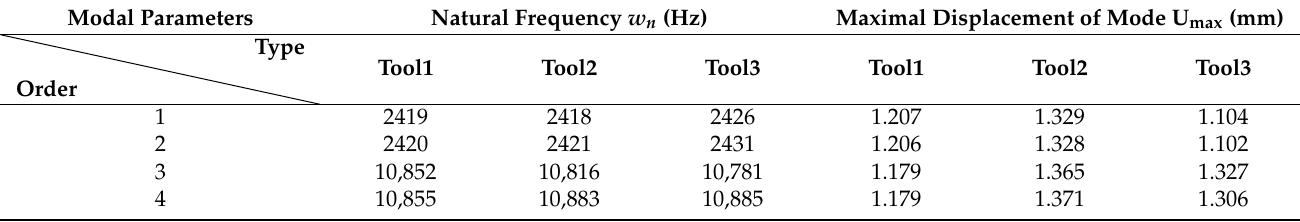
Figure 8. Dynamic performance for different end mills: ( a ) modal analysis; ( b ) cutting force. Table 2. Modal parameters for different end